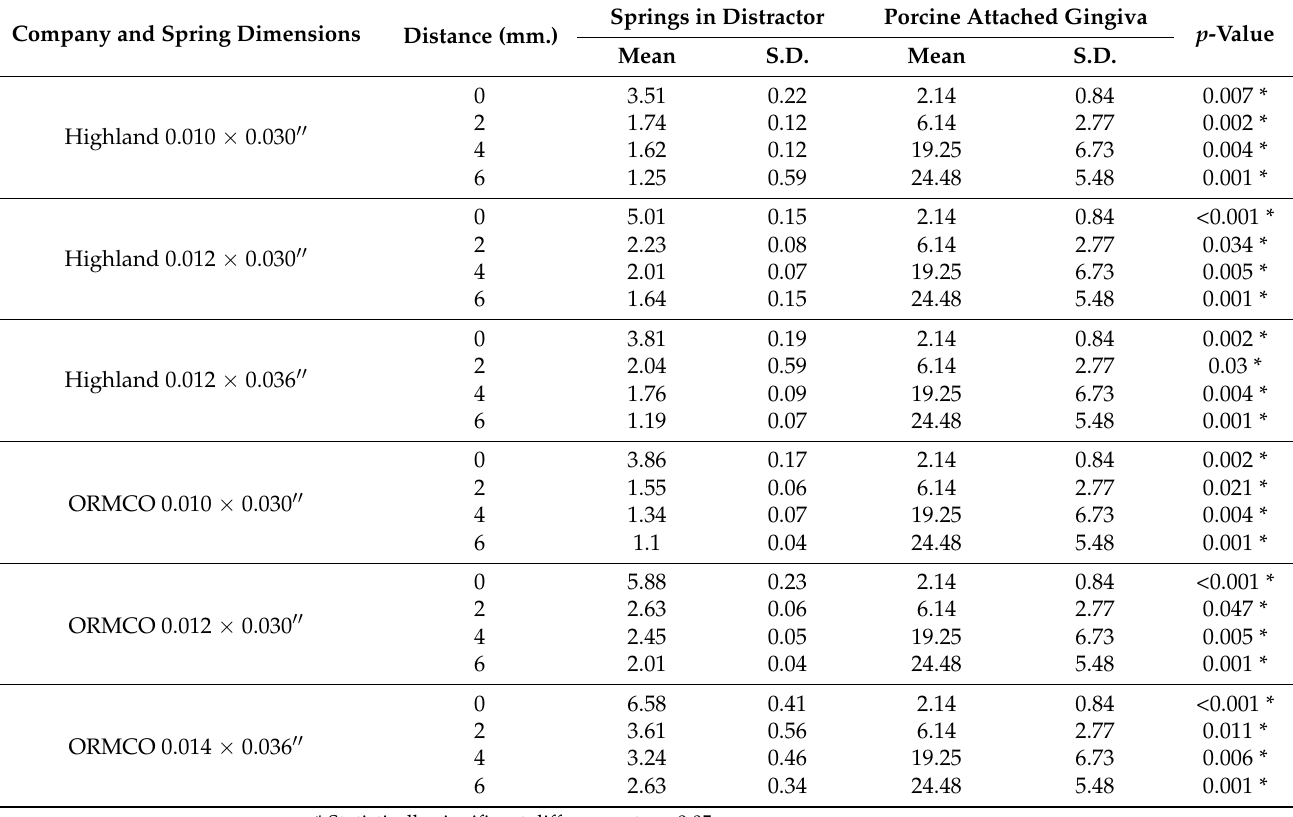
Table 4. Comparison of the mean load of tensile test between forces from NiTi springs tested in the distractor and forces from porcine attached gingiva.